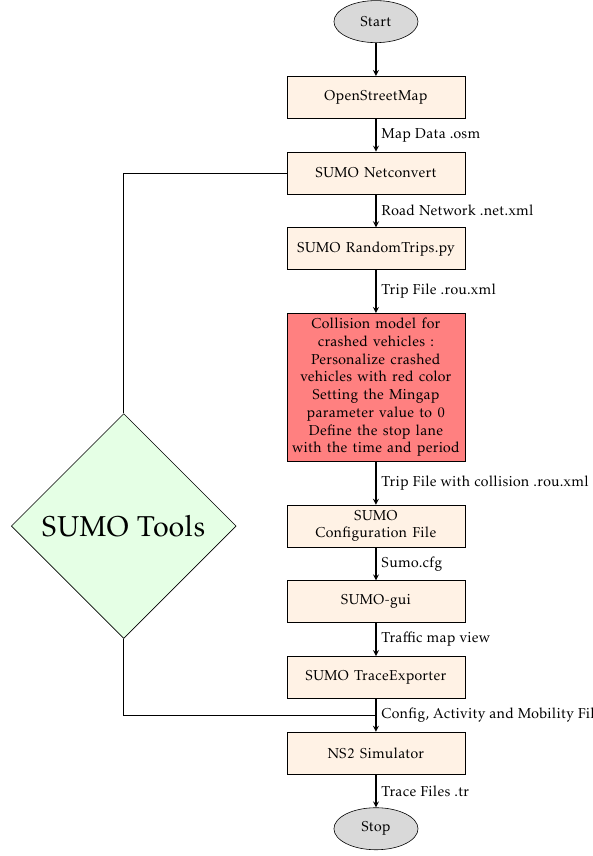
Figure 7. Simulation Process with Collision model using OpenStreetMap, SUMO, and NS2 for Scenario 2